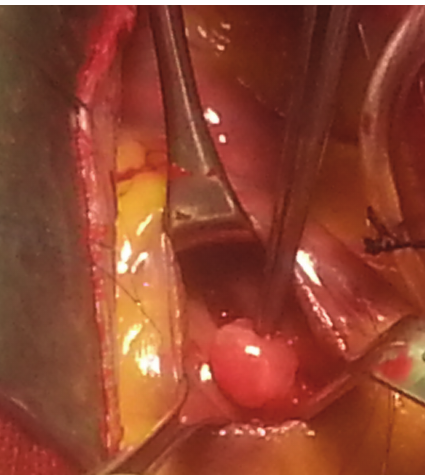
Figure 3: A 1.5 × 1.5 cm polypoid mass was found in right ventriculotomy approach.